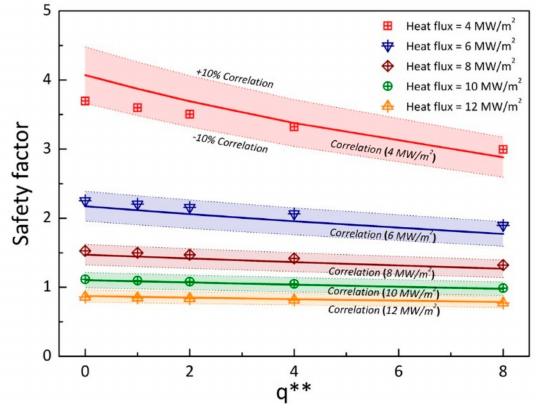
Figure 5. Simulated and correlated analytical results of the safety factor at the vulnerable point with changes in normalized heat flux ( q *) and heat generation ( q **).